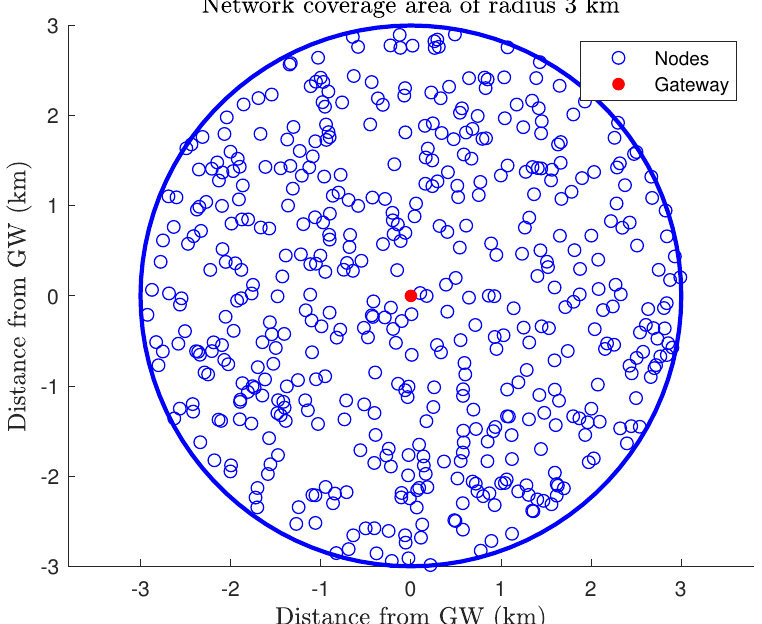
Figure 1. Uniform distribution of ¯ N = 500 nodes in a circular network area of radius R = 3 km, with the gateway ( GW ) at the